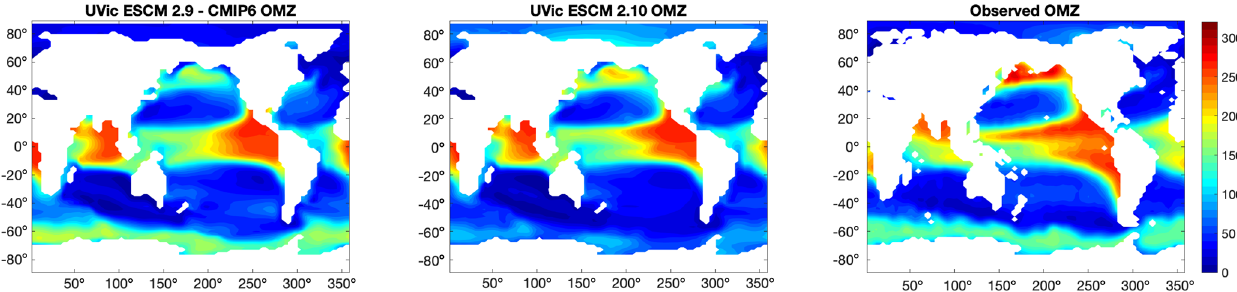
Figure 16. Maps of apparent oxygen utilization in approx. 300m depth (i.e. the depth of oxygen minimum zones, OMZs; in µmolkg − 1 ) for the published UVic ESCM version 2.9-02 (Eby et al., 2013) spun up and forced with CMIP6 forcing, for the UVic ESCM 2.10, and for the World Ocean Atlas 2018 (Garcia et al.,